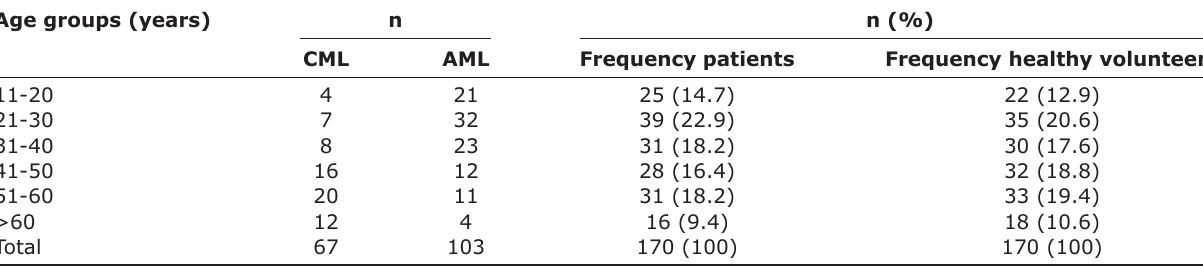
Table-1: Patients age distribution. Age groups (years)